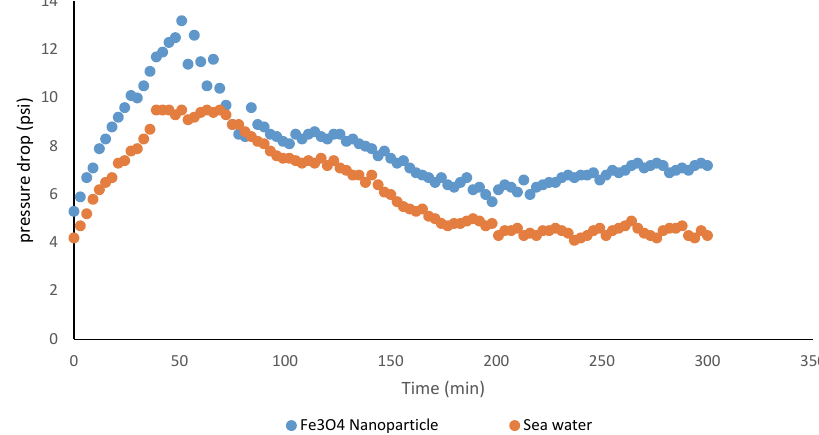
Fig. 10: Pressure flocculation in the system after emulsion flooding containing iron oxide nanoparticles in the seawater